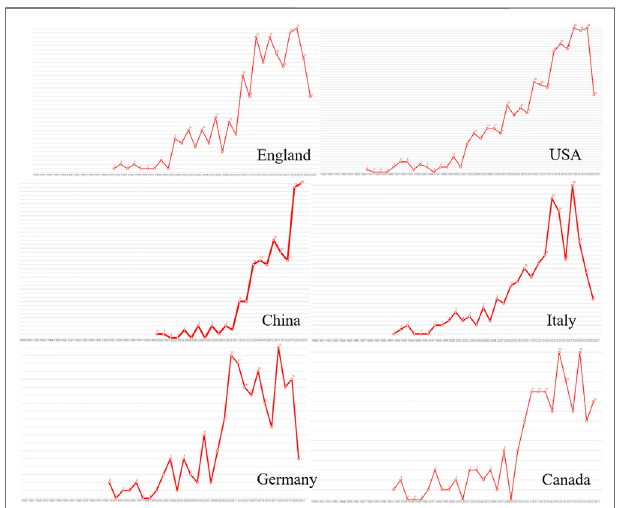
FIGURE 4 | Annual number of COPD drugs-related studies in each country from 1980 to 2021.